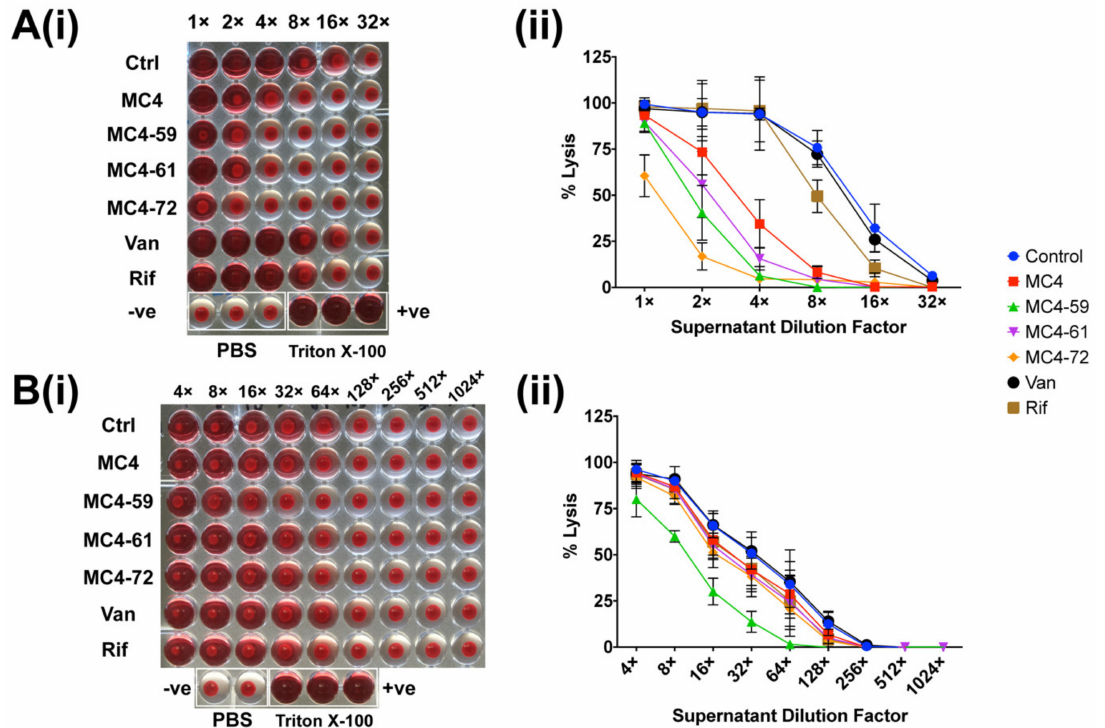
Figure 5. E ff ects of selected nusbiarylins on α -toxin-mediated lysis of rabbit red blood cells (RBCs) in ( A ) S. aureus ATCC ® 25923 and ( B ) MRSA USA300 (readings normalised with maximum as 100%) at subinhibitory concentrations, shown as ( i ) plate image and ( ii ) % lysis plot derived from absorbance changes. Supernatants from both drug-treated and untreated overnight bacterial cultures were serially diluted ( × = folds diluted) and incubated with suspension of packed rabbit RBCs, with plain phosphate-bu ff ered saline (PBS) as negative lysis control and 1% Triton X-100 as positive lysis control. Experiments were repeated in duplicates and representative data presented. Van: vancomycin; Rif: